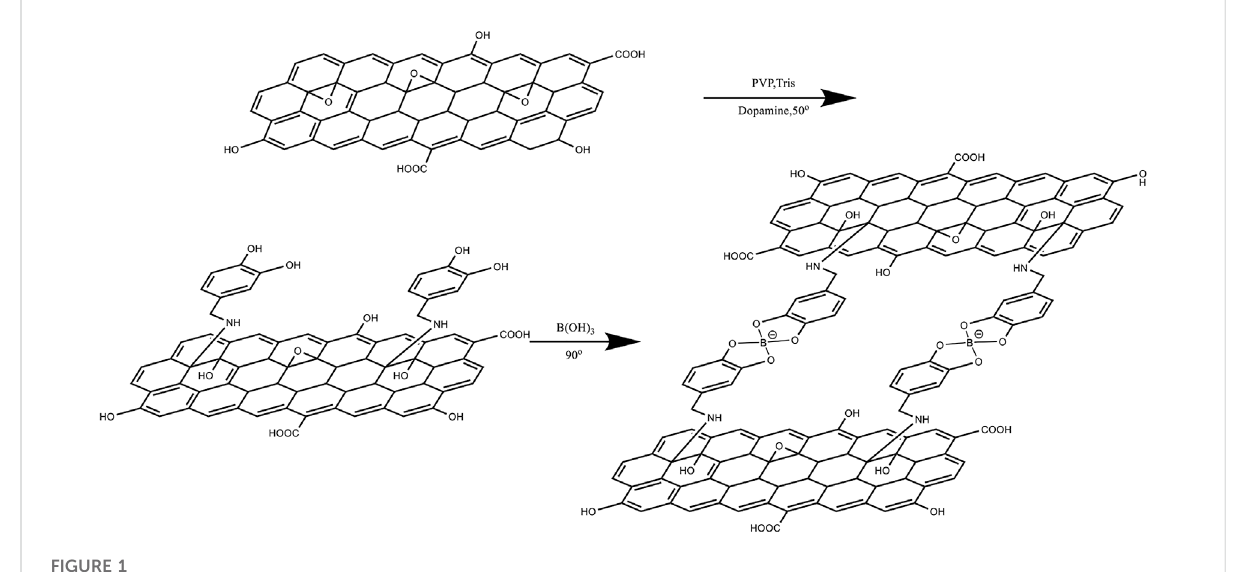
FIGURE 1 The synthetic route of